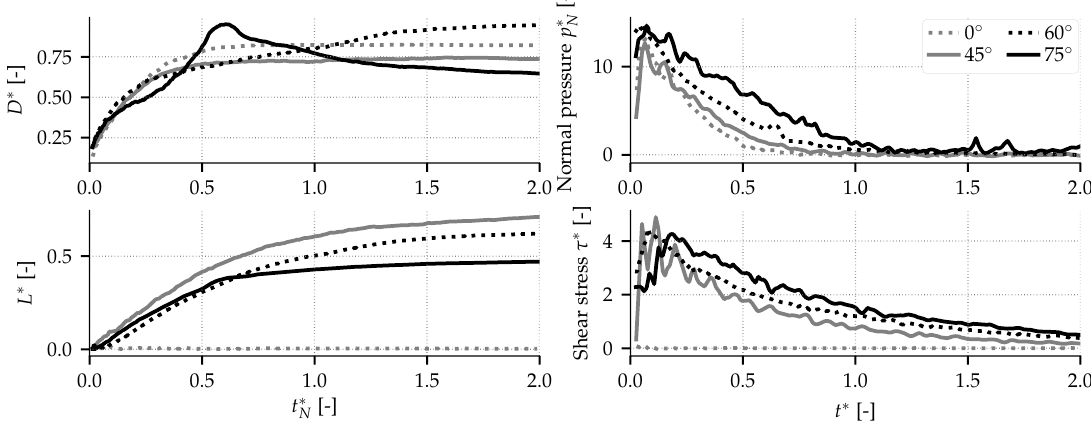
Figure 16. Influence of the impact angle on the transient of a cube presenting its edge parallel to the tangential velocity